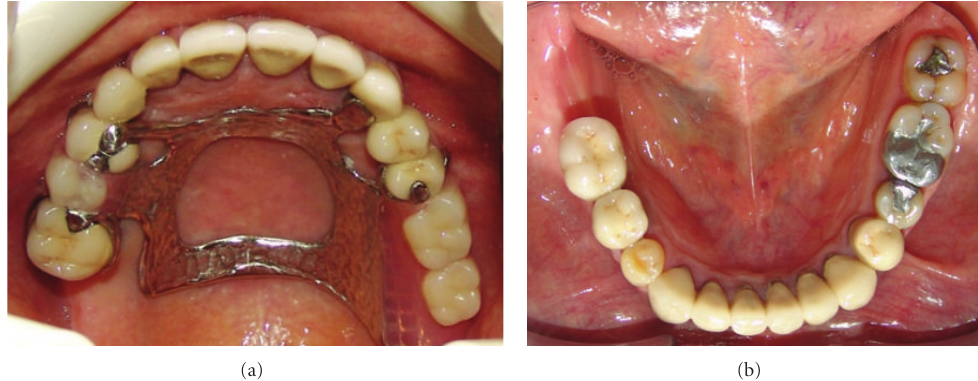
Figure 5: Occlusal view of the maxillary (a) and mandibular (b) arch after treatment.